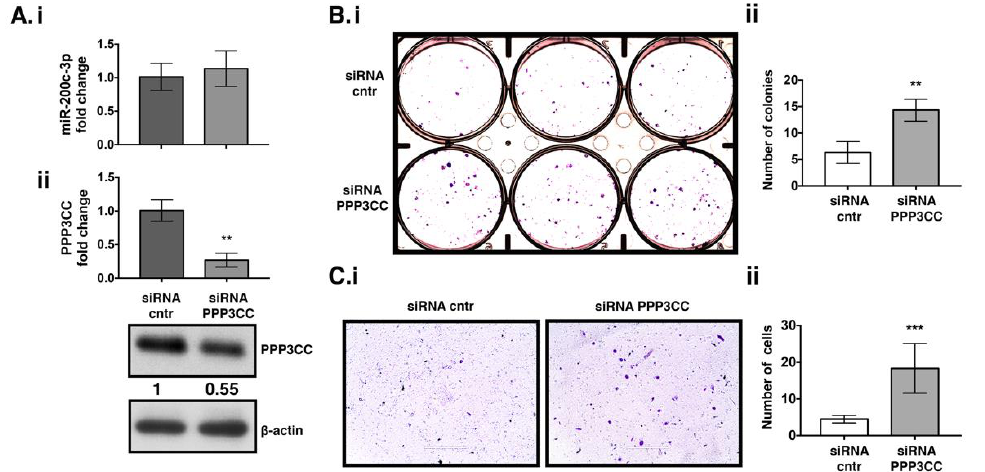
Figure 4. PPP3CC knockdown in EOC cells increases colony formation and migration ability. UWB 1.289 + BRCA1 cells were transfected for 144 h with PPP3CC siRNA ( Ai ): RT-qPCR miR-200c-3p expression, normalized to RNU6 housekeeping gene ( Aii ): PPP3CC transcript was assessed by RT- qPCR. Normalization was performed with the GAPDH housekeeping gene. Fold change expression comparing to the control was calculated as 2 −ΔΔCt . WB analysis of PP3CC expression. β-actin was used as a loading control. Values shows the fold change in PPP3CC expression in UWB1.289 + BRCA1 cells transfected with PPP3CC siRNA comparing to the control (cntr) siRNA, calculated by Image J densitometric analysis ( Bi ): 144 h post-transfected cells were placed in a 6-well plates and stained with crystal violet after 10 days to estimate colony formation ( Bii ): Graph shows the average number of colonies per well, calculated using the count tool (PhotoshopCC2017). The experiments were performed in triplicates and were repeated at least twice. ( Ci ): Transwell migration assay at 144 h post-transfection shows the cells able to traverse the transwell membrane, colored in blue violet. Inhibition of PPP3CC increased the number of migrated cells. ( Cii ): Graph shows the average number of migrated cells, calculated in each of the 6 selected areas in each well, by using the count tool (PhotoshopCC2017). Magnification 10× (white scale bar: 400 μm). A two-tailed unpaired t -test was applied for statistical significance, ** p < 0.01, *** p < 0.001.